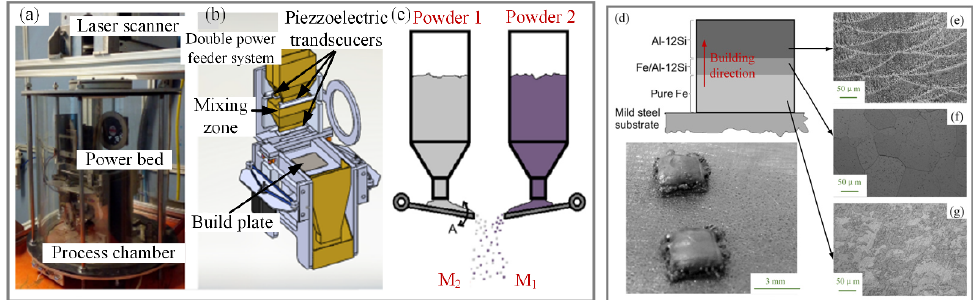
Figure 8. ( a ) Schematic of the SLM, ( b ) Design of the powder feeder system, ( c ) Schematic of the powder feeder for mixing powders, ( d – g ) Sample and the cross-sections of different layers of FGMs with pure Fe/Al-12Si [58].